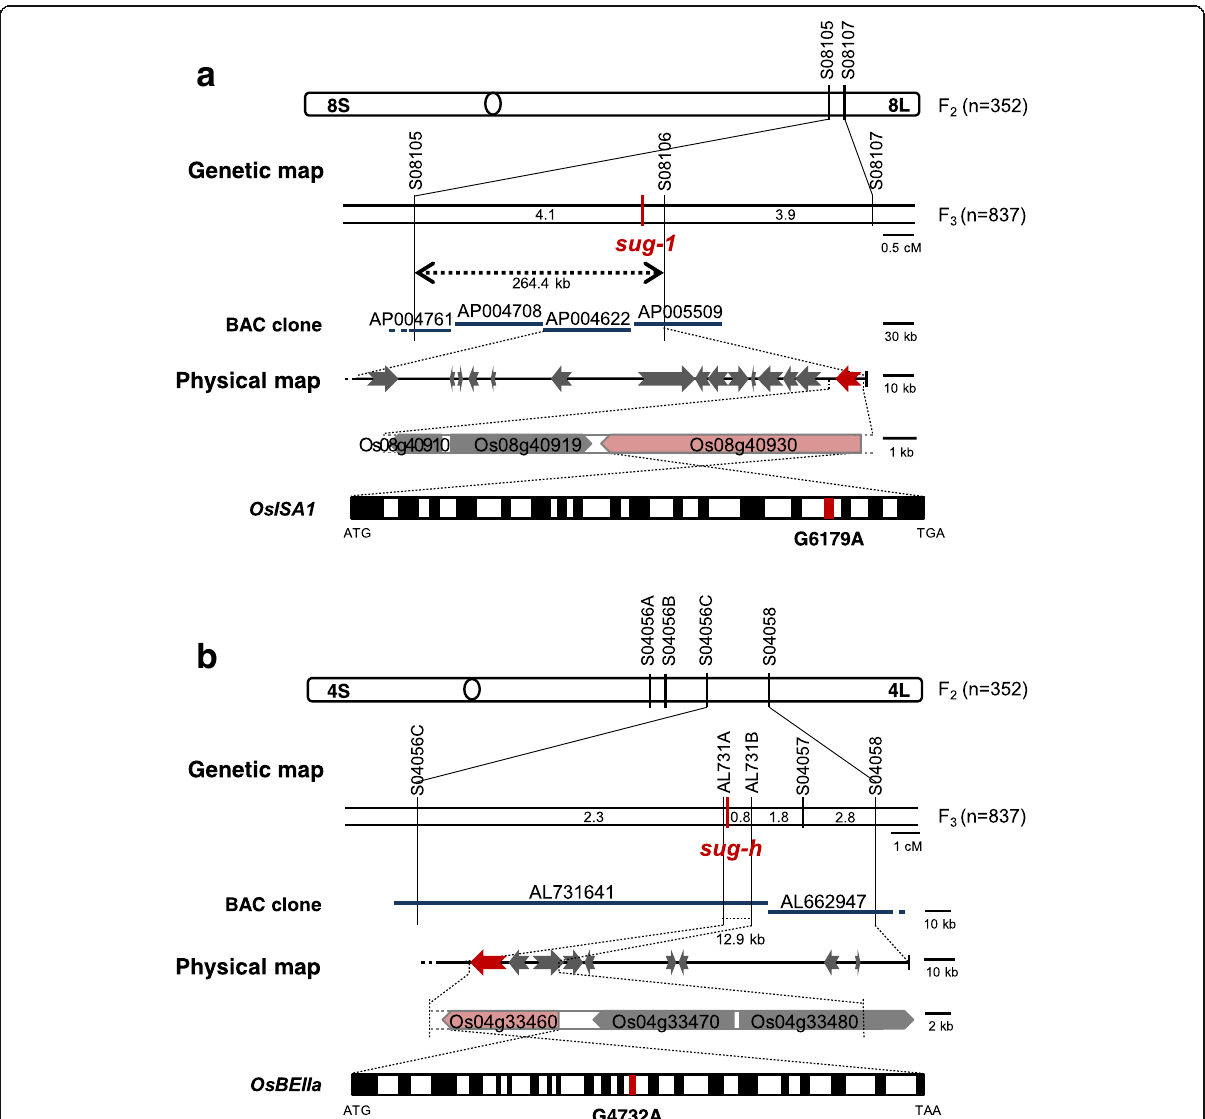
Fig. 4 Map-based cloning of the sug-h mutant. a Candidate region of the sugary gene was on the long arm of chromosome 8. Candidate gene of the first bulked segregant analysis, Os08g40930, was located on the AP005509 BAC clone and contained 18 exons ( black boxes ) and 17 introns ( white boxes ). A point mutation, G to A, occurred in the 15th exon ( red box ). b Schematic representation of OsBEIIa on the long arm of chromosome 4. Candidate region of the gene related to the sug-h mutant was located within the AL731641 clone. The physical distance was approximately 12.9 kb, which included three candidate genes. Schematic structure of the candidate gene, Os04g33460, contained 22 exons ( black boxes ) and 21 introns ( white boxes ). A point mutation, G to A, occurred in the 13th exon ( red box ). Gray arrows indicate the main genes with known functions within the candidate region. Red arrow indicates the candidate gene. ATG and TGA/TAA indicate the initiation and termination codons,